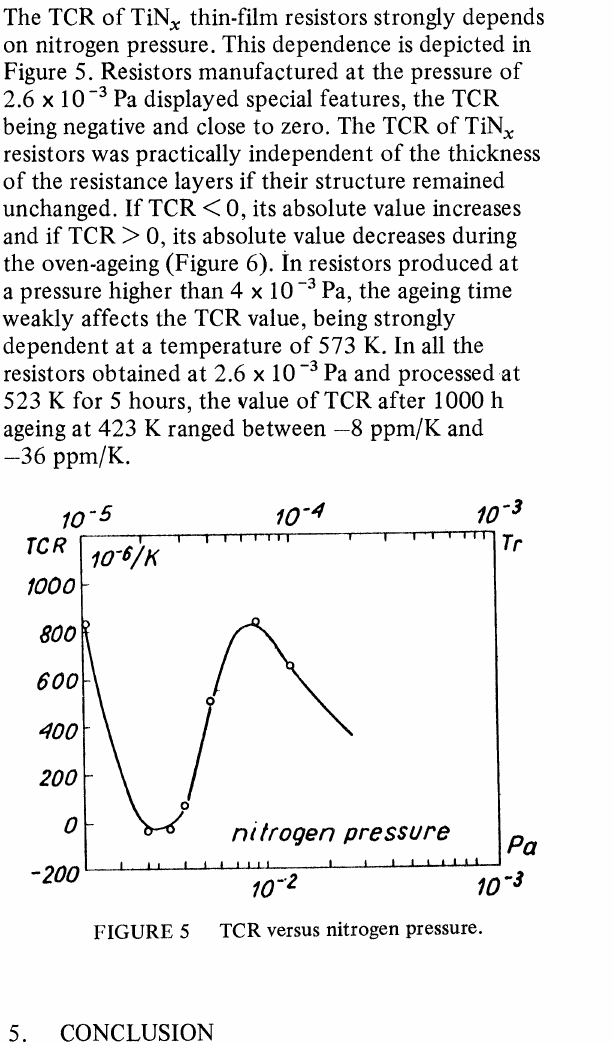
TCR versus ageing time for various ageing temperatures and nitrogen pressures.